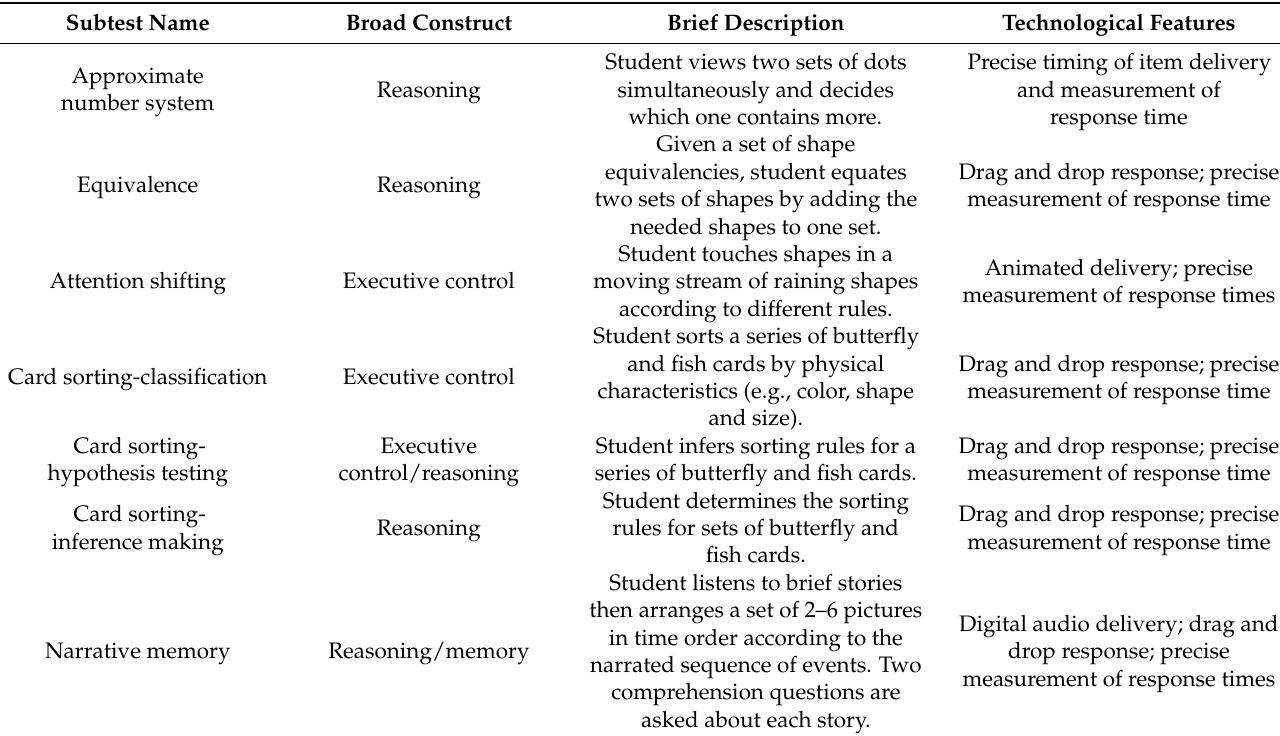
Table 2. Subtest case